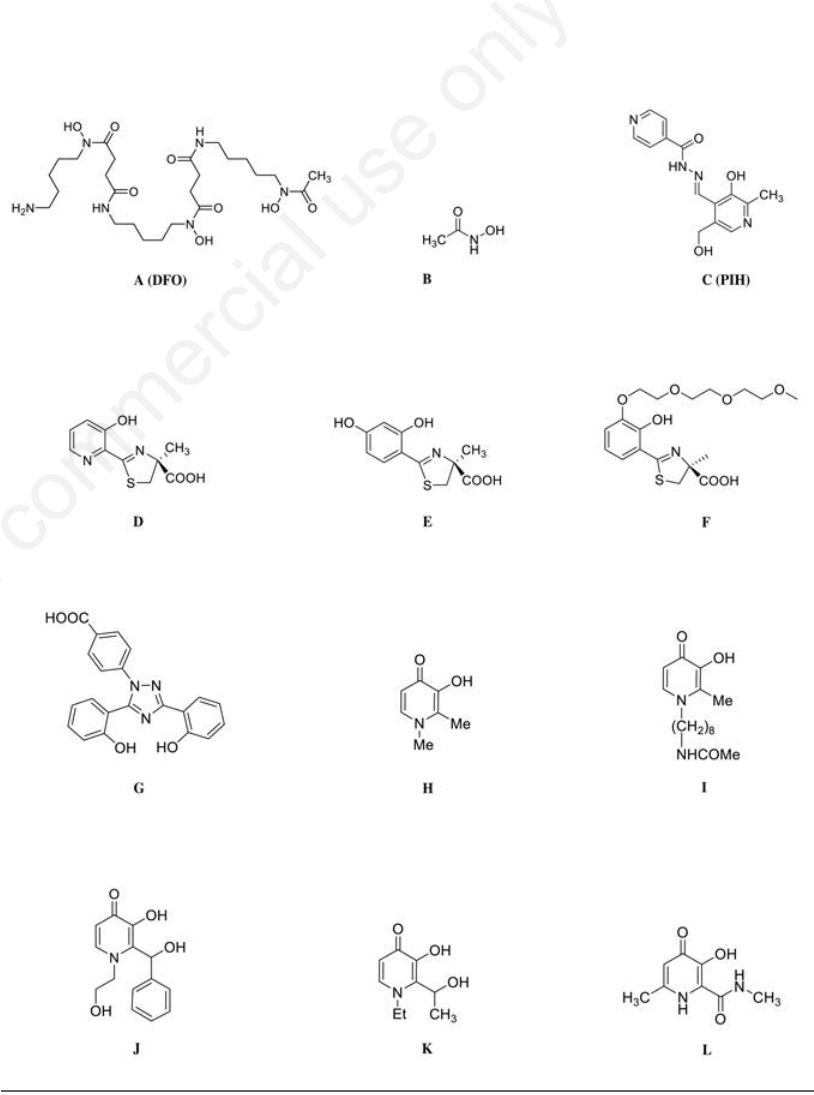
Figure 1. Structures: A) desferrioxamine (DFO); B) acetohydroxamic acid; C) pyridoxal isonicotinoyl hydrazone (PIH); D) desferrithiocin; E) deferitrin; F) deferitazole; G) deferasirox; H) deferiprone; I) CM1; J) CGP65015; K) CP365; L)